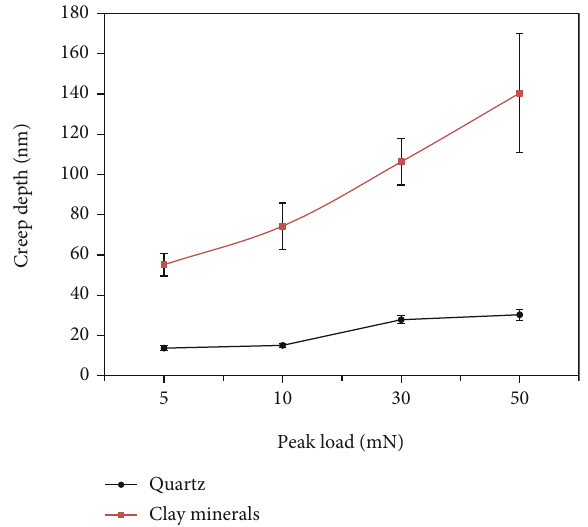
Figure 6: Creep depths of quartz and clay minerals at various peak loads. Error bars are one standard